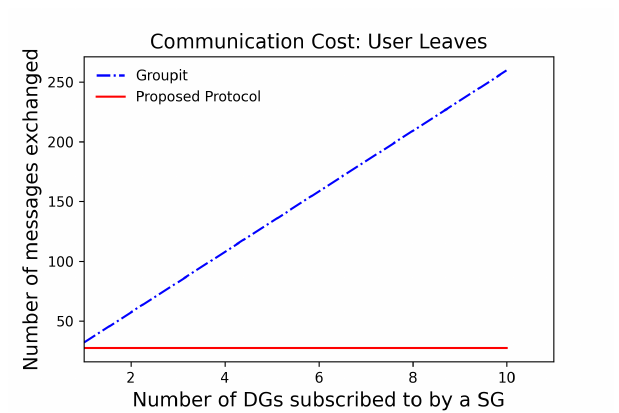
Figure 10. The figure shows the communication costs under GroupIt and the proposed protocol versus the number of DGs subscribed to by the user for the case when a user leaves group SG x